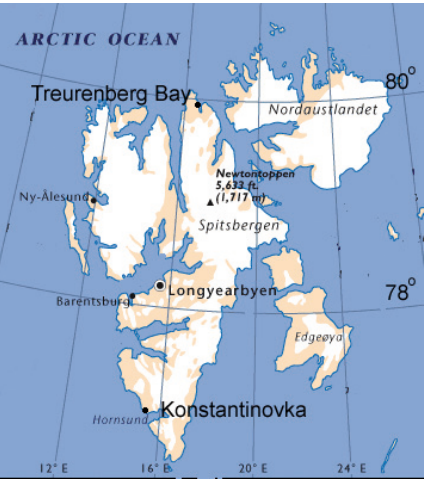
Fig. 1. Map of Spitsbergen showing the positions of the Russian station Konstantinovka and the Swedish station at Treurenberg Bay.